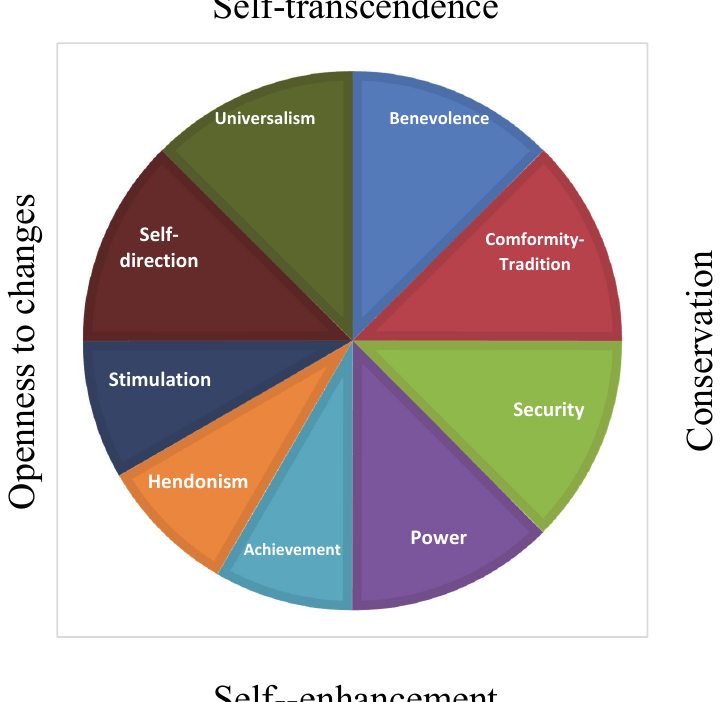
Fig. 1 . Theoretical Model of Relations among 10 Motivational Types of Values Source: (Schwartz,